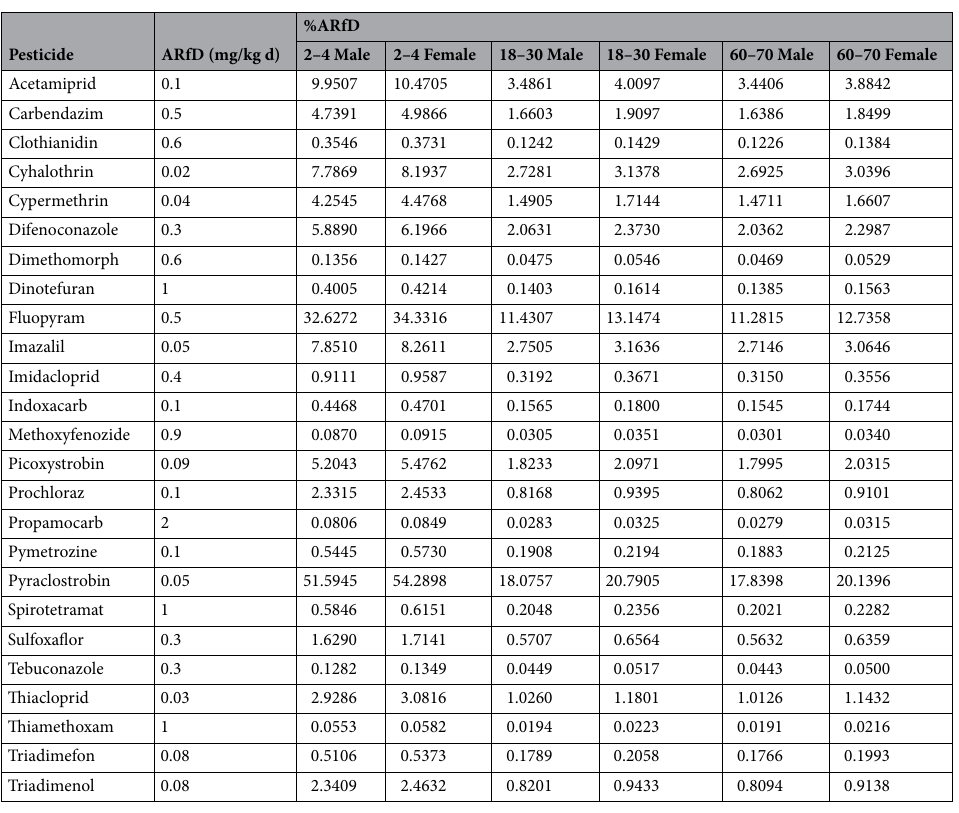
Table 3. Acute dietary exposure assessment of detected pesticide residues in fruits among different Chinese consumer